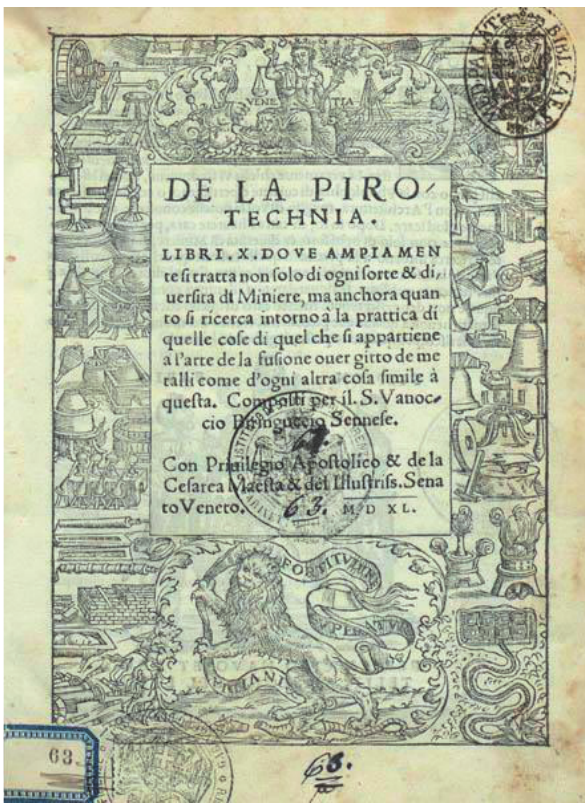
Fig. 2. Title page of De la Pirotechnia , published in Venice in 1540 (https://bibdig.museogalileo.it/Teca/ImageProvider?image=./000/00